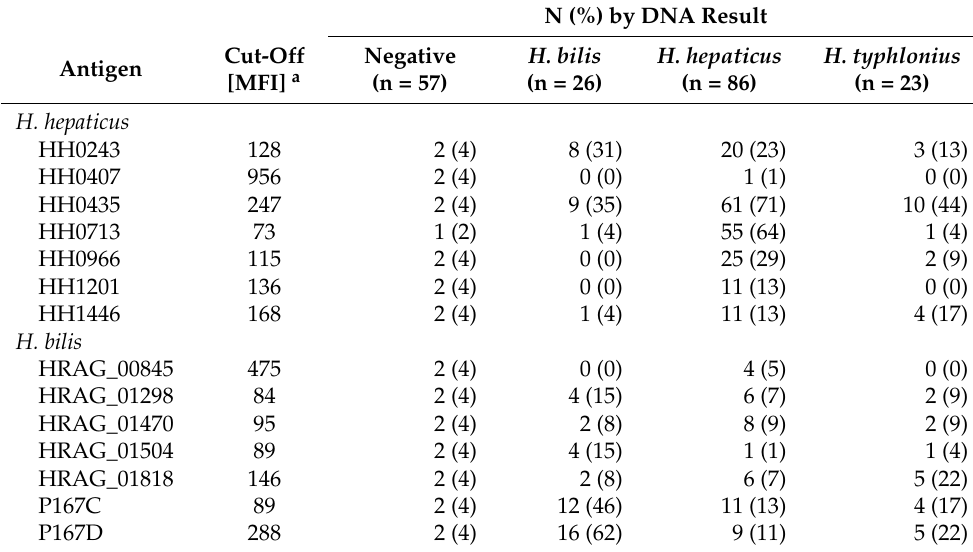
Table 5. Sero-positivity to H. hepaticus and H. bilis antigens by Helicobacter multiplex DNA finder result. N (%) by DNA